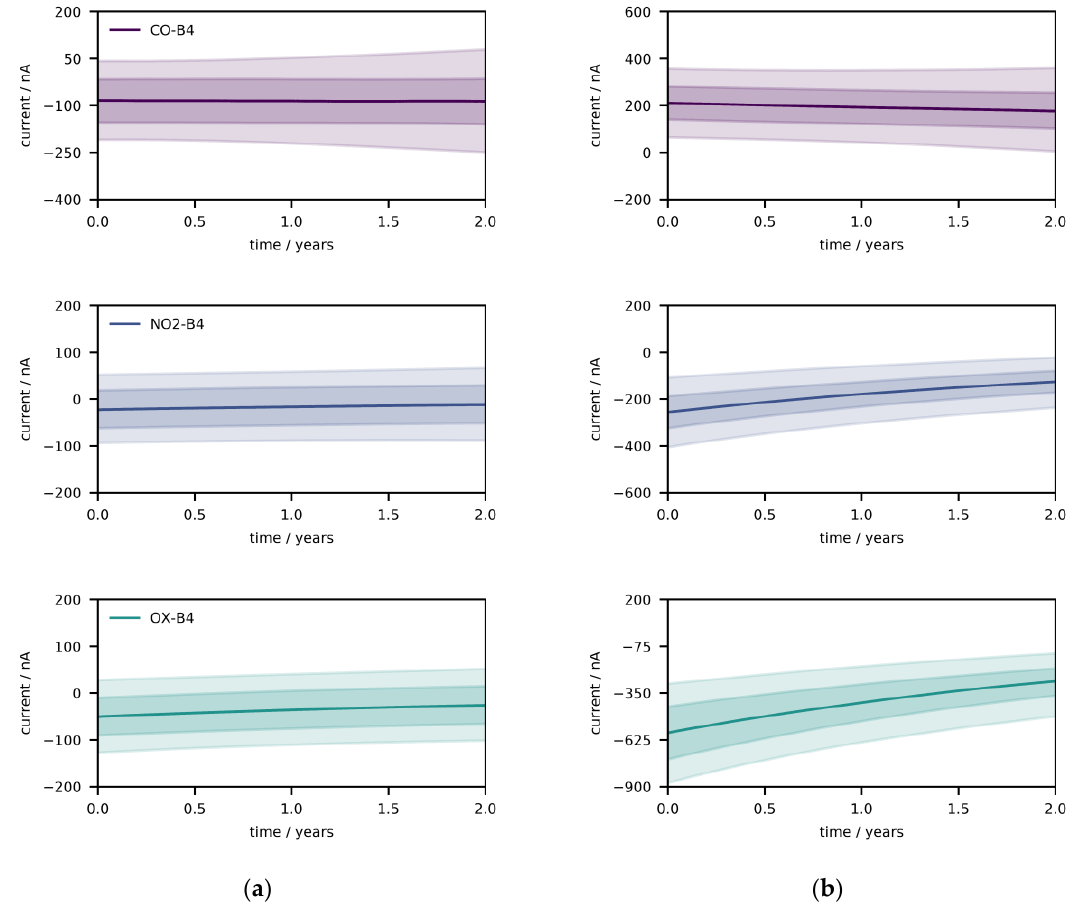
Figure 4. Distribution of sensor signals (q 0.50 , q 0.25–0.75 , q 0.05–0.95 ) over time under constant conditions. ( a ) At low fractions (CO: 50 ppb, NO 2 : 50 ppb, O 3 : 50 ppb), the baseline drift is mildly recognizable (particularly for CO-B4). ( b ) At high fractions (CO: 600 ppb, NO 2 : 600 ppb, O 3 : 600 ppb), the curvature due to the sensitivity drift is clearly visible (particularly for NO 2 -B4 and OX-B4); this drift leads to convergence towards the baseline.